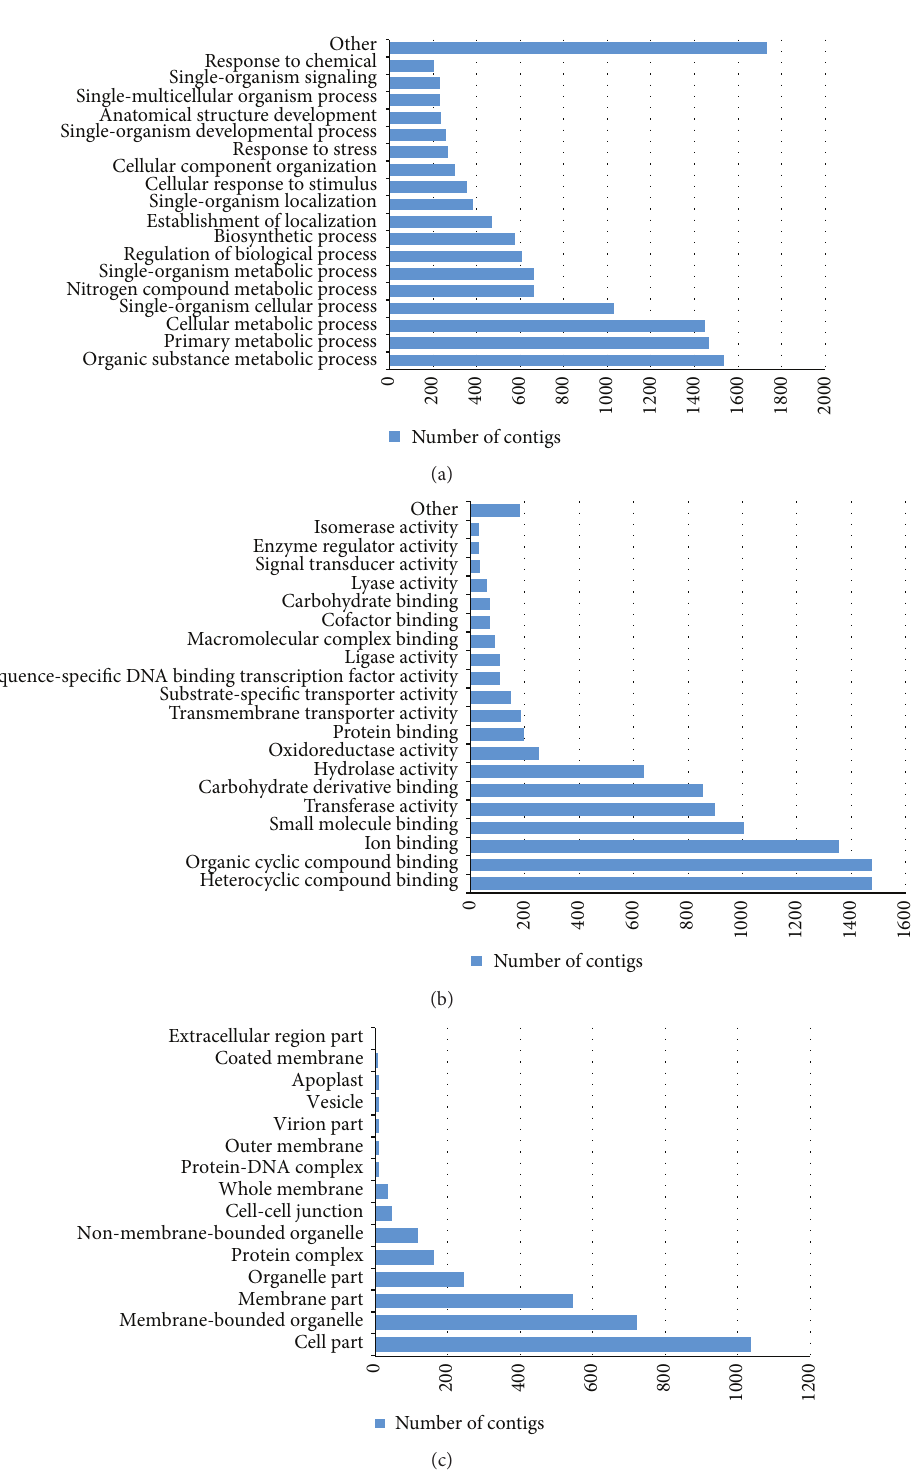
Figure 4: Gene Ontology (GO) classification of nodule-specific contigs. GO subcategories of (a) “biological process,” (b) “molecular function,” and (c) “cellular component” are shown. of pea, we analyzed the 14,998 sequences of the “nodule only” clusters using TransDecoder software [23]. As a result, 593 putative full-length ORFs were found in 536 contigs (Supplementary File